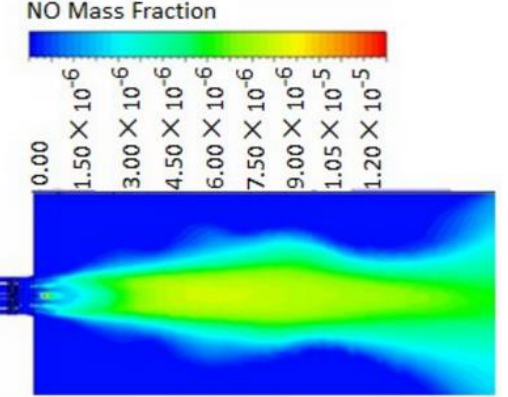
Figure 10. Building a mathematical model of the nitric oxide distribution based on the data collected by the neural network.